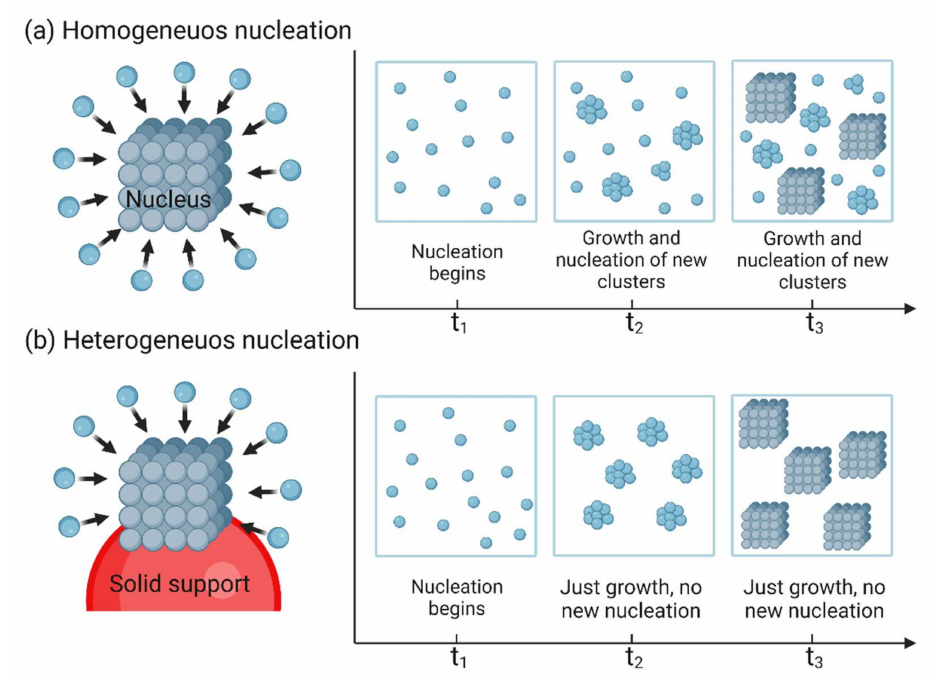
Figure 4. Schematic presentation of ( a ) Homogeneous nucleation and ( b ) Heterogeneous nucleation and reaction coordinates as a function of time. Images were created with